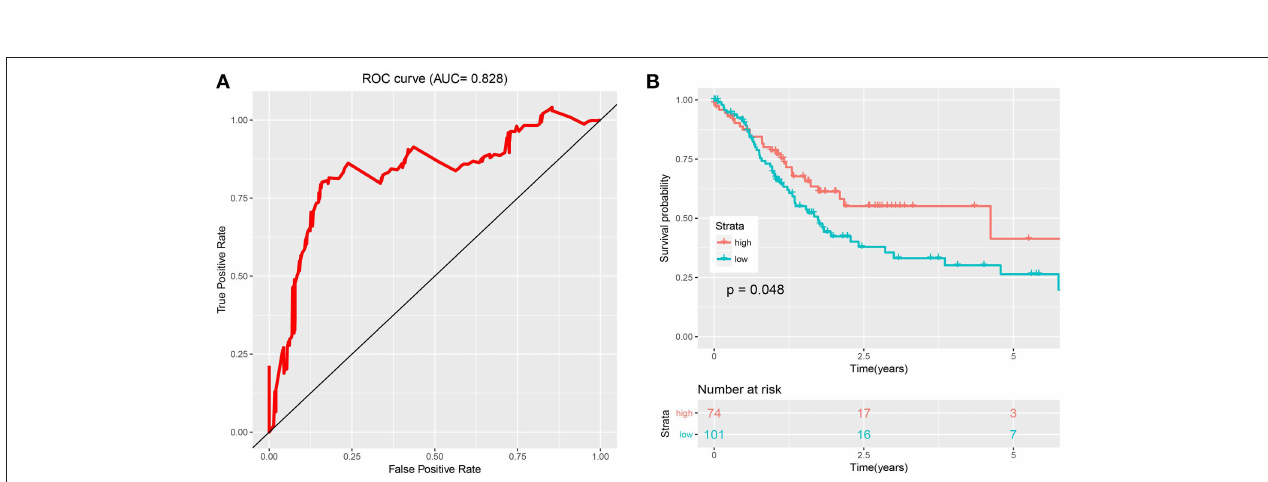
FIGURE 3 | Evaluation and validation of the risk signature. (A) The ROC curve of eight-snoRNAs’ model. (B) The survival curve of two groups (low risk and high risk) based on optimal cutoff in testing set. group. Thus, the risk biomarker established by the eight-snoRNA signature served as an independent prognostic factor (hazard ratio = 3.43, 95% confidence interval: 1.93–6.09, P =